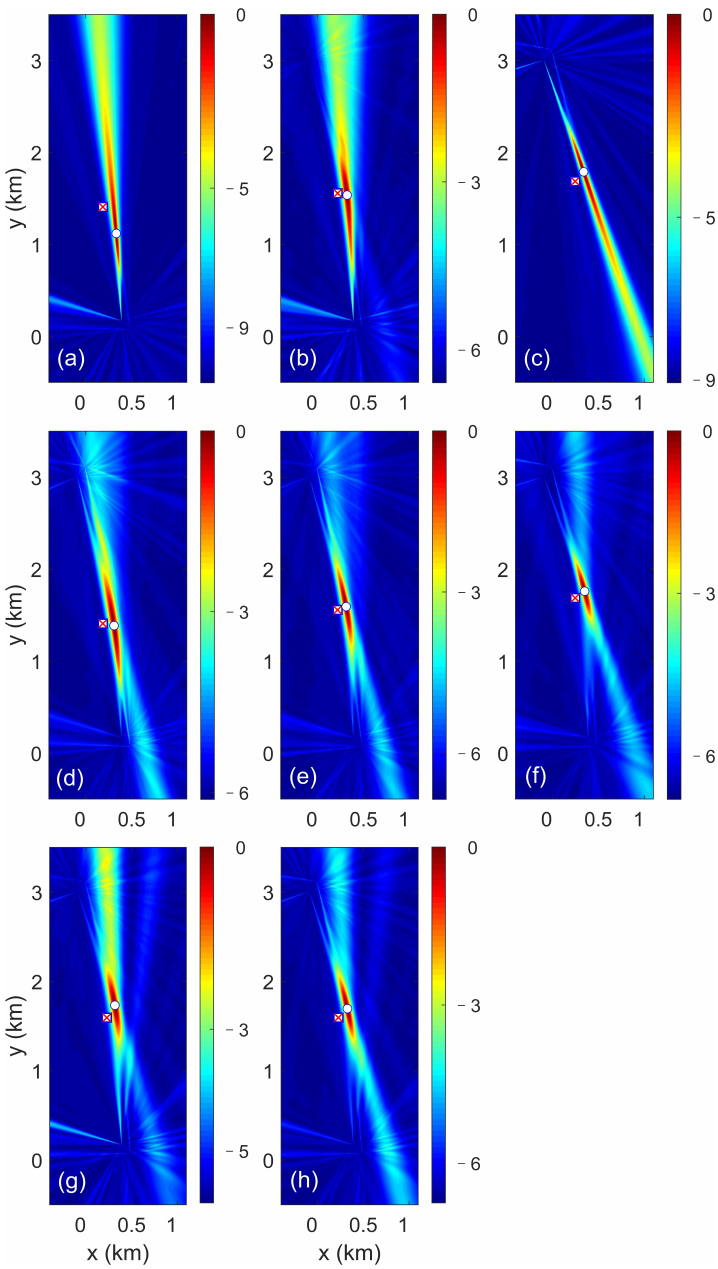
Figure 5. (Color online) ( a – c ) Spatial spectra of GMA at segments 3, 4, and 5, respectively. ( d – f ) Spatial spectra of N-MUSIC at segments 3, 4, and 5, respectively. ( g , h ) Spatial spectra of GMA and N-MUSIC at 17.5 s past segment 4. Results are with 232 Hz. True source position is indicated by red cross symbol inside the square. Estimated source position is indicated by white